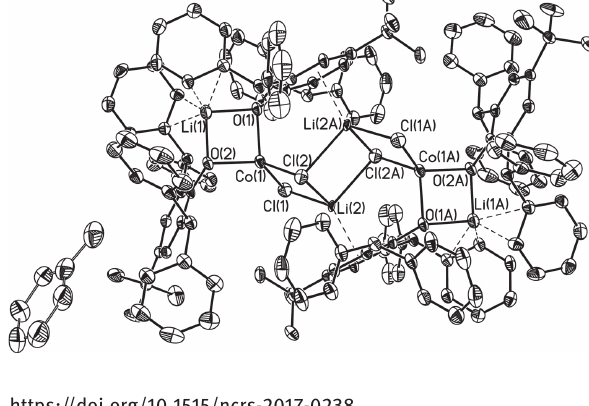
Table 2: Fractional atomic coordinates and isotropic or